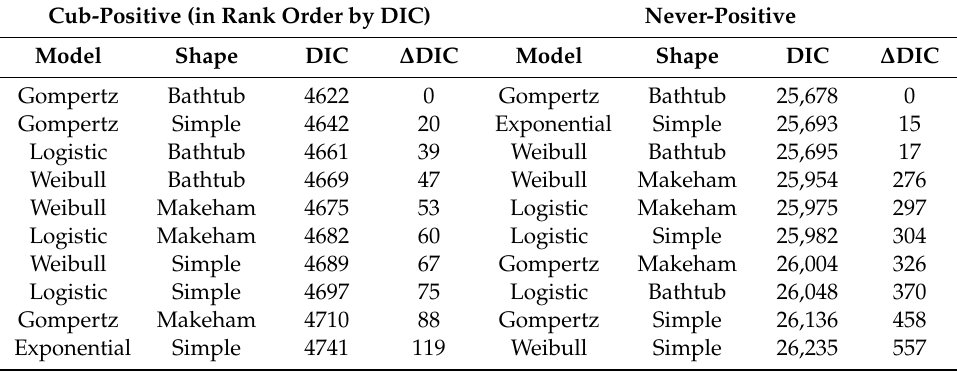
Table 3. Ranked list of tested mortality functions, fitted to data from a wild population of European badgers naturally infected with bovine tuberculosis. Badgers were separated into two health states (“cub-positive”: tested positive in the first year of their lives; “never-positive”: never tested positive throughout their lives). Deviance information criterion (DIC) values are given for each model, as well as corresponding di ff erences ( ∆ DIC) with respect to the “best” model. Substantial support for the “best” model is indicated when alternative candidate models have ∆ DIC > 3